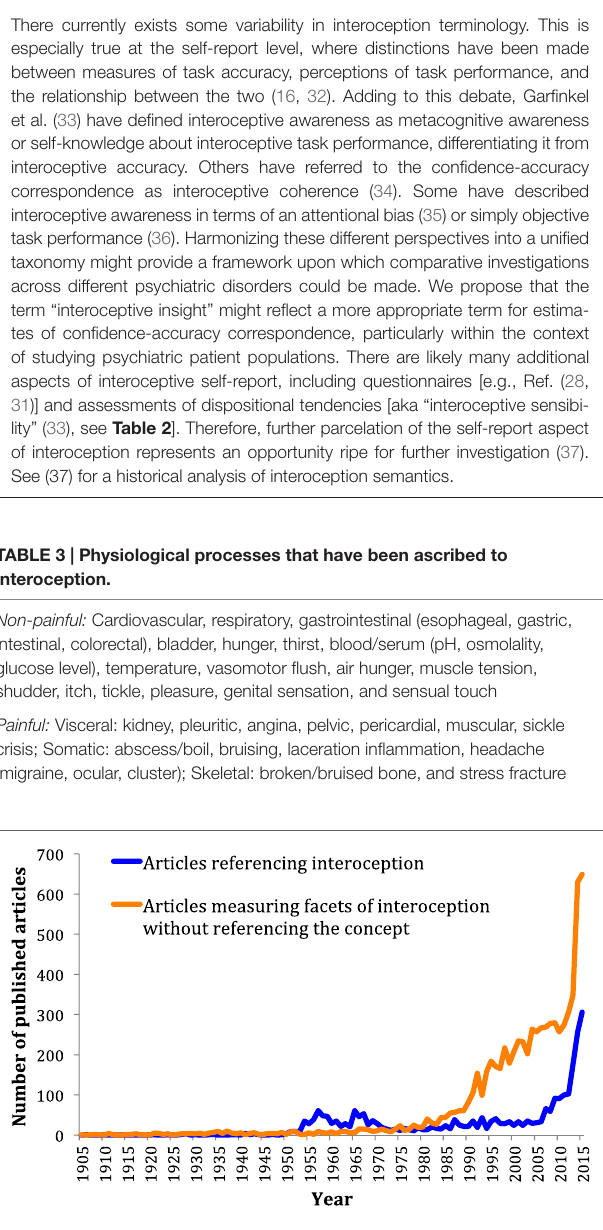
FiGURe 1 | Number of articles published on interoception versus articles published measuring interoceptive facets without directly referencing the concept . The timeline starts in 1905, 1 year before the publication of Charles Sherrington’s book, “The integrative action of the nervous system,” which introduced the term interoception into the literature.